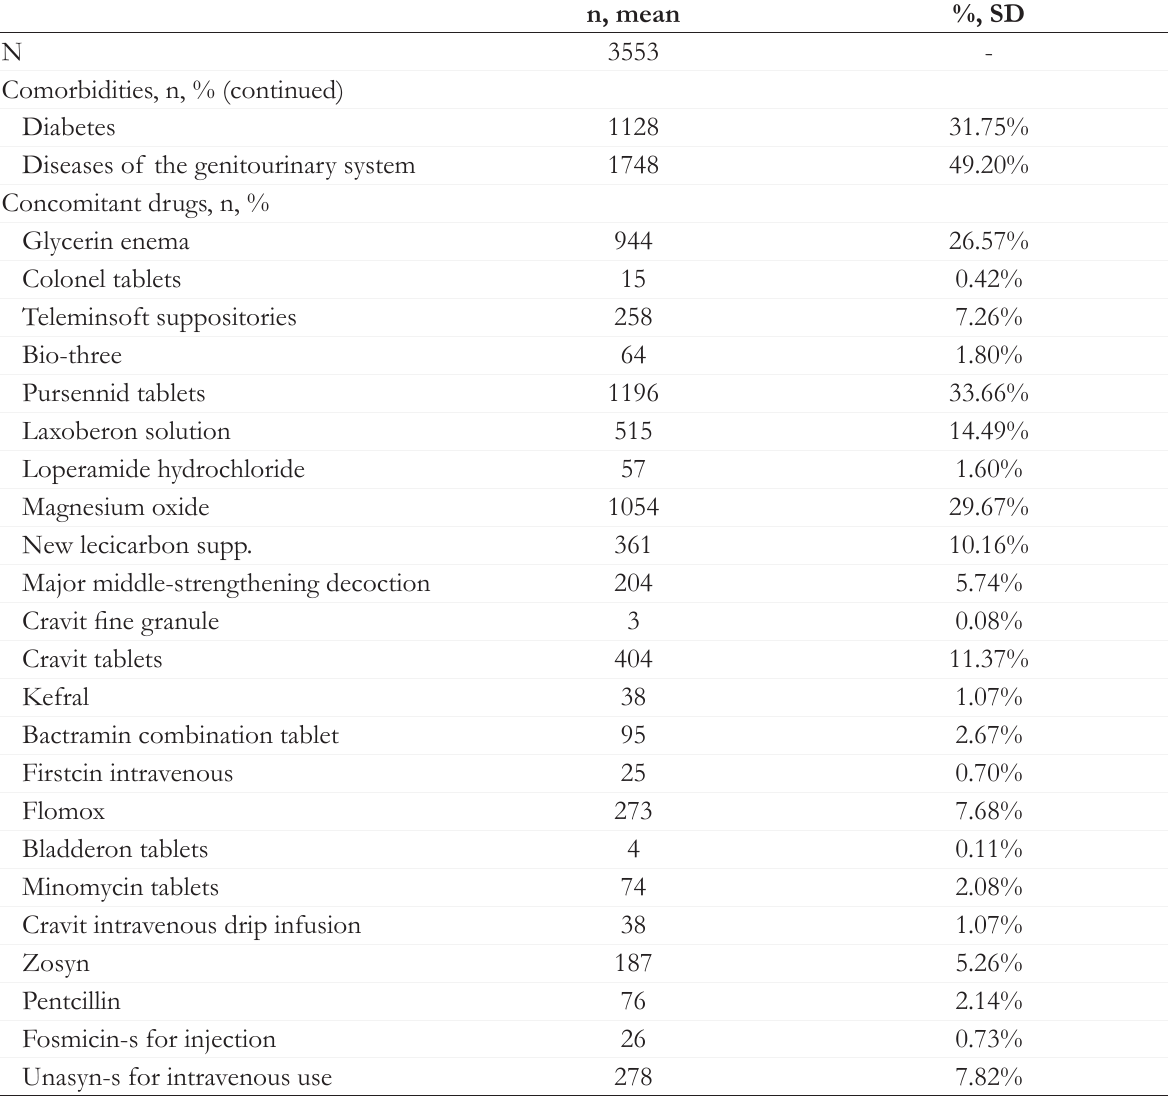
Table 5. Characteristics of Patients Included in the MDV Data Analysis - continued n, mean %, SD N